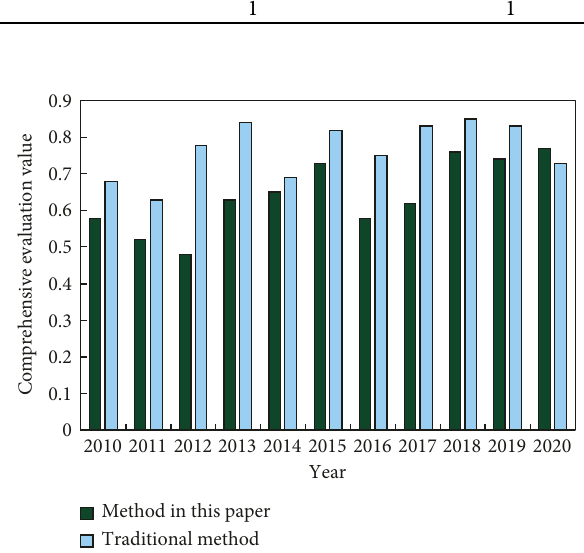
Figure 11: Comparison of the results of comprehensive evaluation of ecological environment quality by using this method and tra- ditional